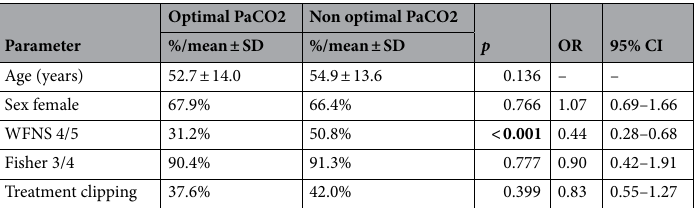
Table 2. Statistical analysis of demographic and clinical baseline characteristics for optimal and non-optimal PaCO2 groups. Statistically significant p -values are marked bold.